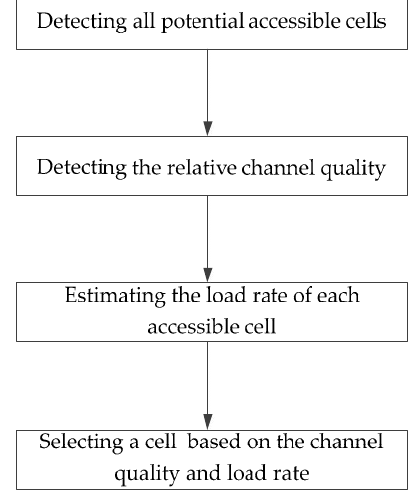
Figure 11. An illustration of the cell or mode selection procedure.